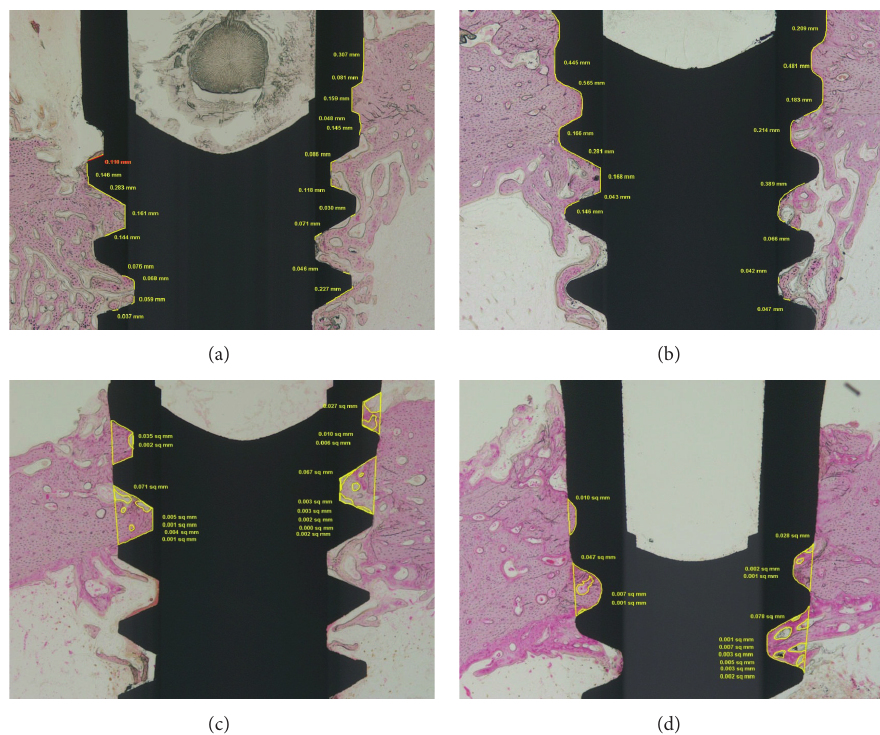
Figure 4: Microscopic photographs of mini-implants 4 weeks after placement (hematoxylin-eosin staining). (a) × 40; machined surface mini- implant in control group; (b) × 40; SLA treated mini-implant in control group; (c) × 40; machined surface mini-implant in DM group; (d) × 40; SLA treated mini-implant in DM group. Yellow marking means bone contact